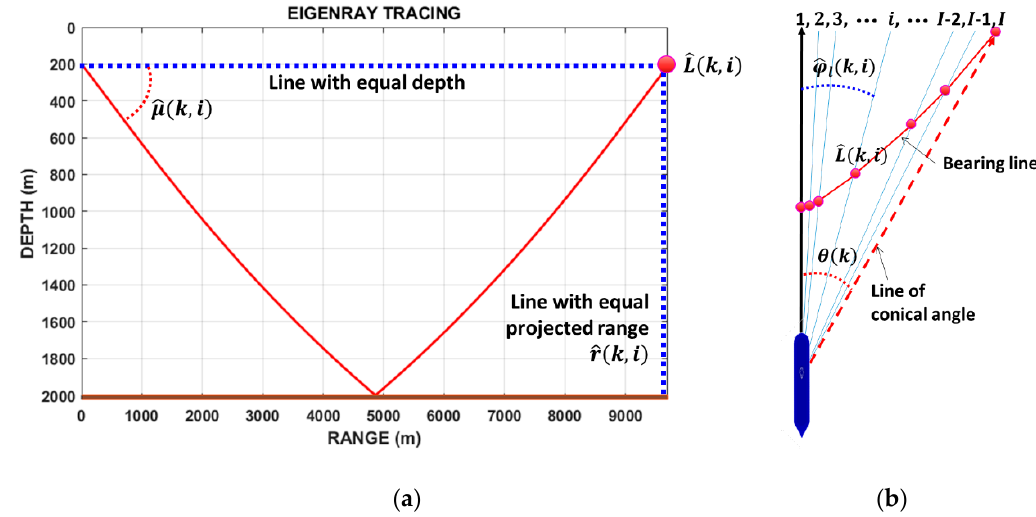
Figure 5. ( a ) Eigenray tracing result conducted to determine the expected target range. The distance at which the ray arrives at an expected target depth after bottom reflection becomes the estimated target range in ˆ ϕ l ( k , i ) direction. ( b ) Top-view illustration showing the line of conical angle and bearing line. For k -th scan, the line connecting I possible target positions estimated using the eigenray tracing is a bearing line (red line in figure).